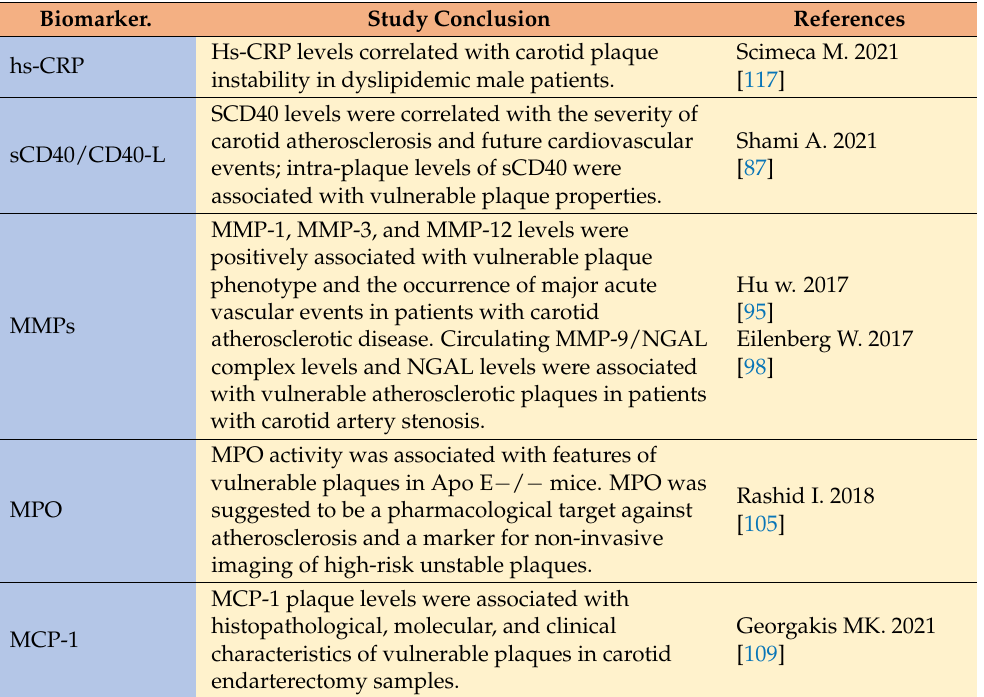
Table 4. Clinical and pre-clinical studies regarding circulating biomarkers involved in the diagnosis of vulnerable atherosclerotic